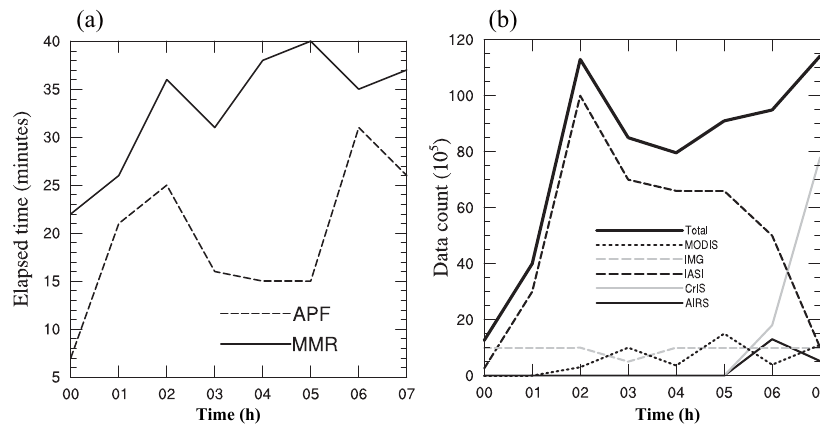
Figure 10. (a) The elapsed time and (b) the data count from 00:00 to 07:00UTC, 15 December 2013.